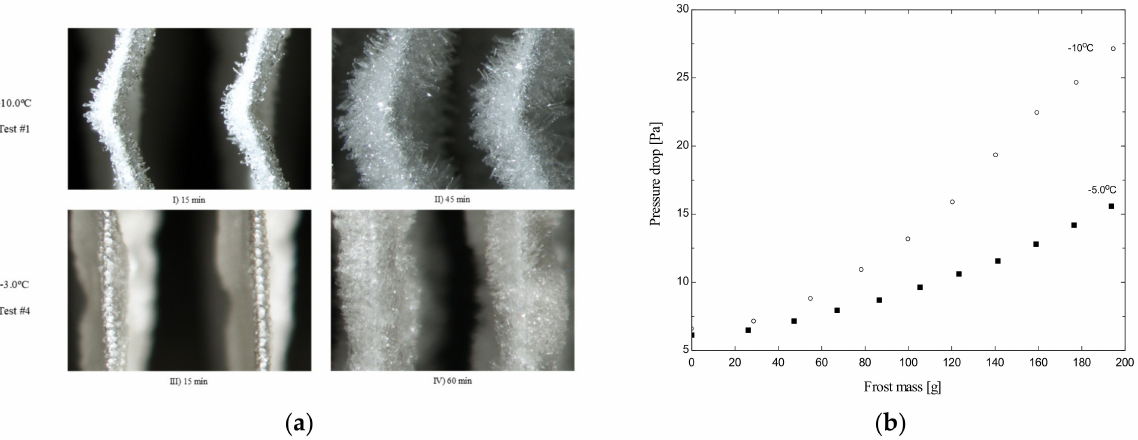
Figure 13. Visualizations of distinct frost layer morphologies ( a ), and their effect on the airside pressure drop ( b )